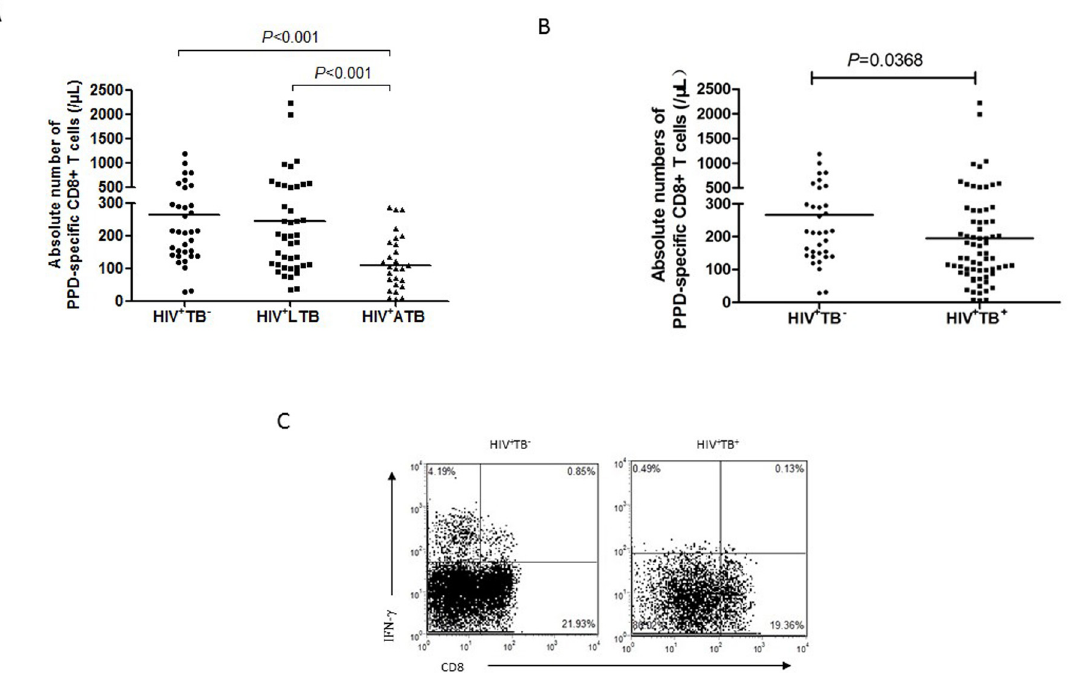
Fig 4. The absolute numbers of PPD-specific IFN- γ + CD8+ T cells in HIV-1 + individuals with or without M . tb co-infections. A . Absolute numbers of PPD-specific IFN- γ +CD8+ T cells in groups of HIV-1 + ATB, HIV-1 + LTB and HIV-1 + TB - . B . Absolute numbers of PPD-specific IFN- γ +CD8+ T cells in HIV-1 + individuals with or without M . tb co-infection. The horizontal lines represent the medians of cell numbers for each group. C . Representative CD3-gated histograms of PPD-specific IFN- γ +CD8+ T cells from cases of HIV-1 + TB - group and HIV-1 + TB + group.